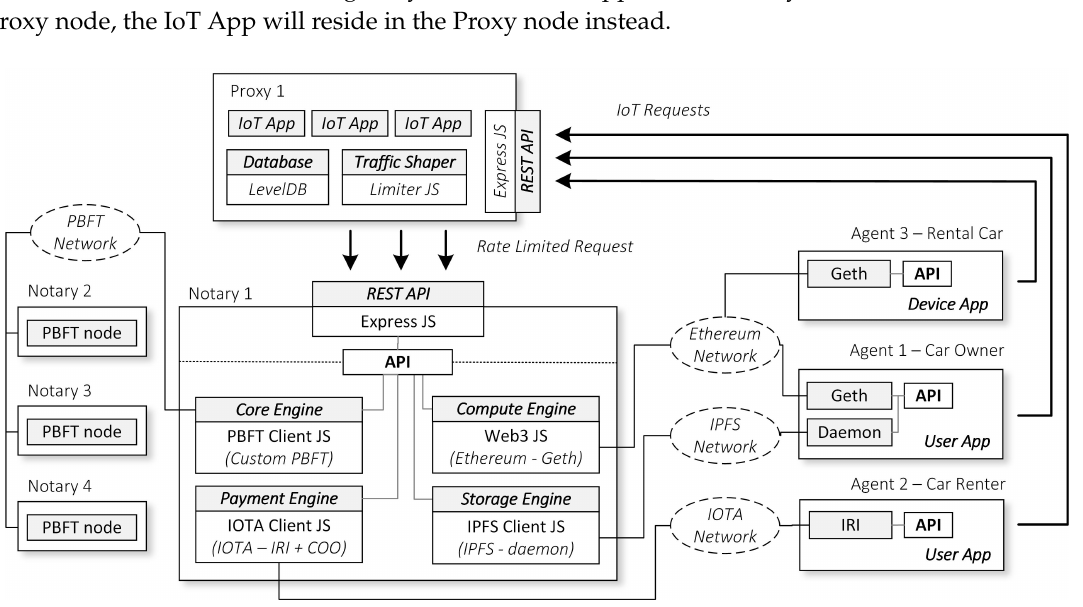
Figure 7. Our implementation diagram for our IoT car rental demo application that consists of Notary nodes, Proxy nodes, and Agent nodes. The IoT App, Device App, and User App are all parts of the car rental